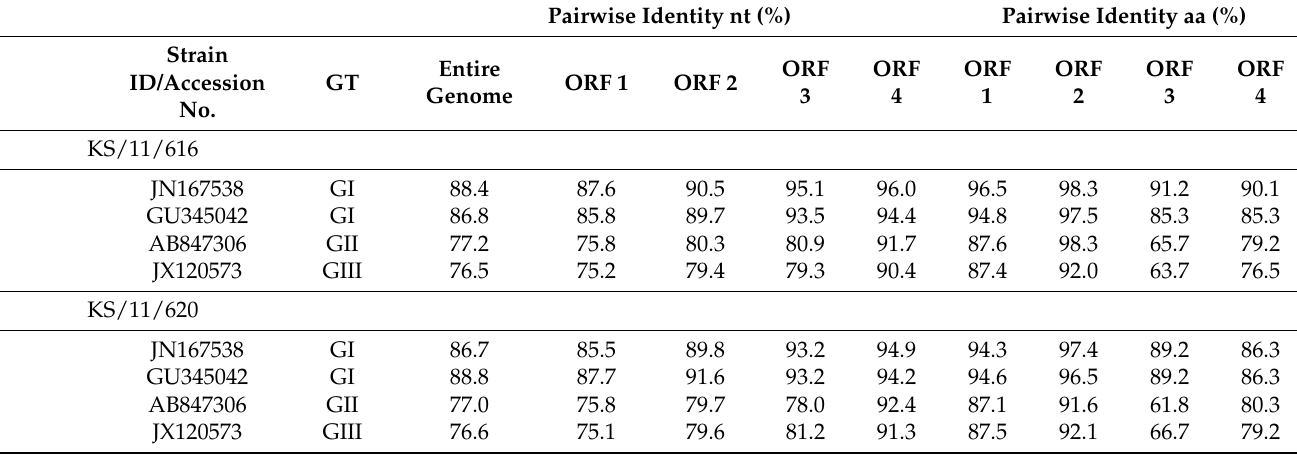
Table 2. Nucleotide and deduced amino acid sequence identity between ratHEV full-length genomes from this study, compared with different ratHEV reference strains detected in Germany, Indonesia, and